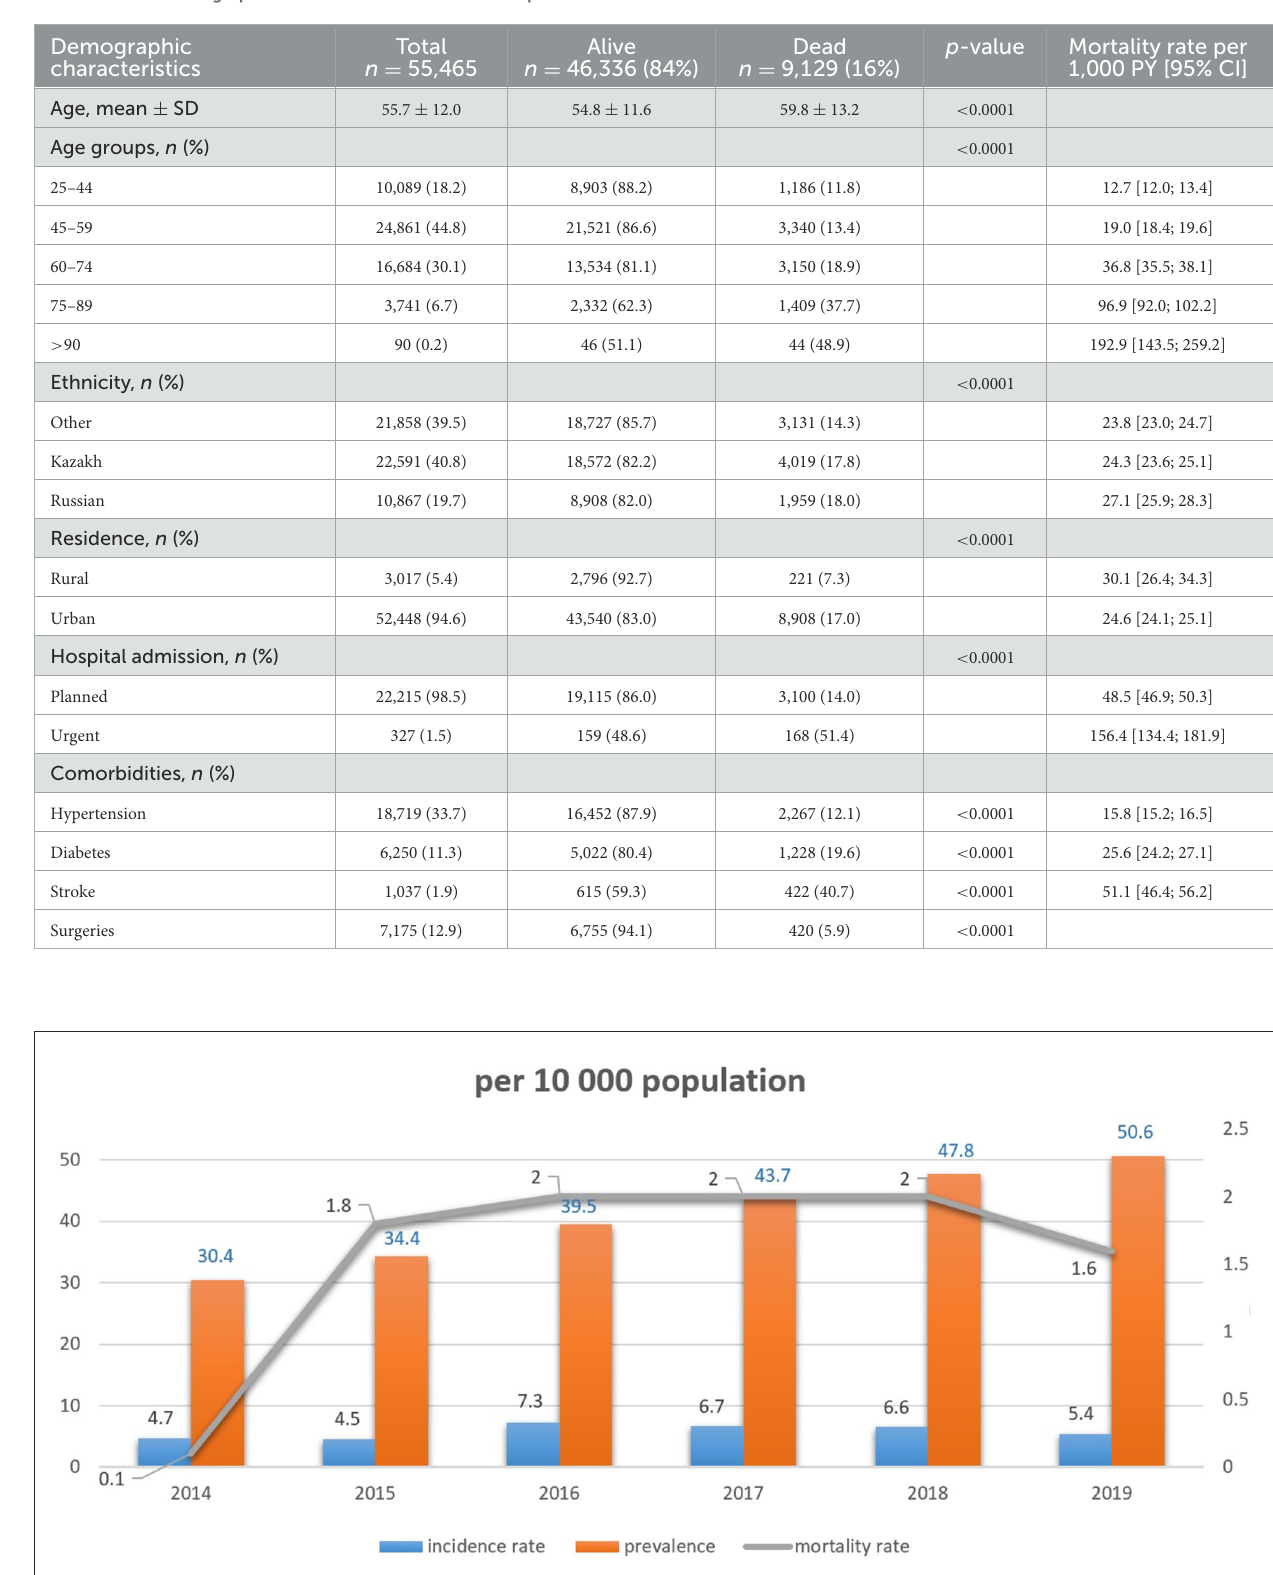
TABLE 1 Socio-demographic and medical characteristics of patients with breast cancer.